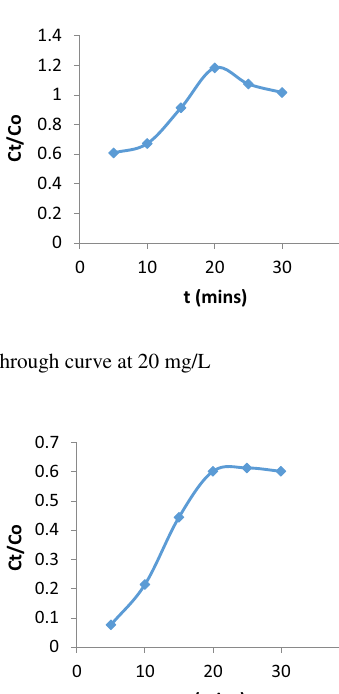
Fig. 2 Energy diffraction spectroscopy of a silver nanoparticle and b silver nanoparticle maize leaf composite